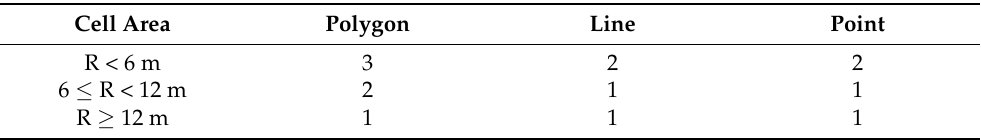
Table 1. The score level of the reference beacon in the cell